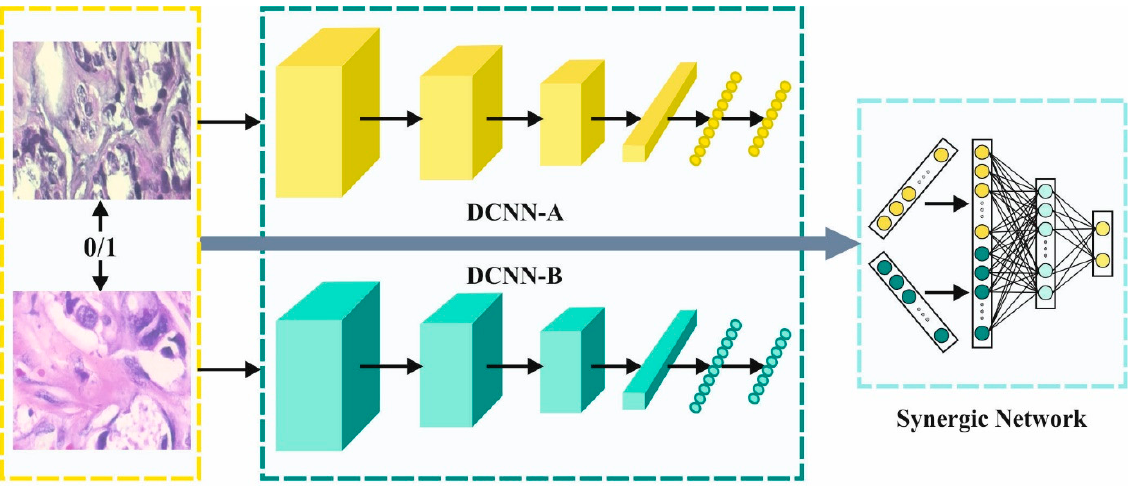
Figure 2. Architecture of SDL network.